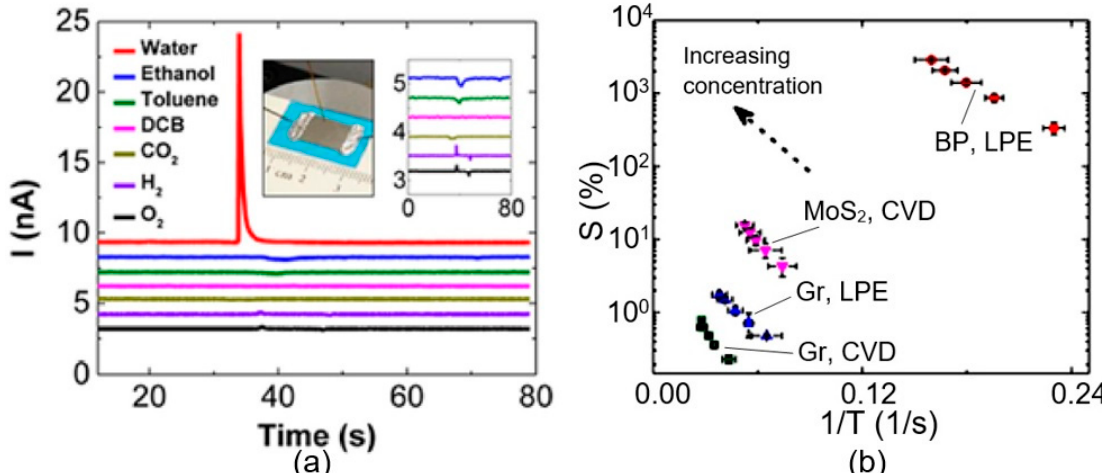
Figure 6. ( a ) The response of the BP sensor to different analytes. The inset (right) magnifies the same curves for clarity. The inset (left) shows the schematic of a typical BP-based sensor fabricated using principles of thick film technology; ( b ) comparison of sensitivities of a typical BP film, graphene and MoS 2 sensors. ( a ) Reproduced with permission from Ref. [95]. Copyright American Chemical Society, 2015. ( b ) Reproduced with permission from Ref. [33]. Copyright Elsevier, 2017. Data from Ref. [94].